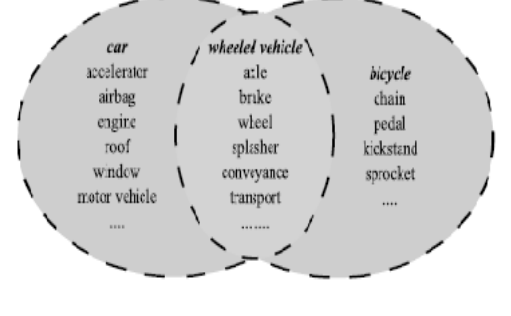
Figure 4 Tversky Model for two words ‘car’ and